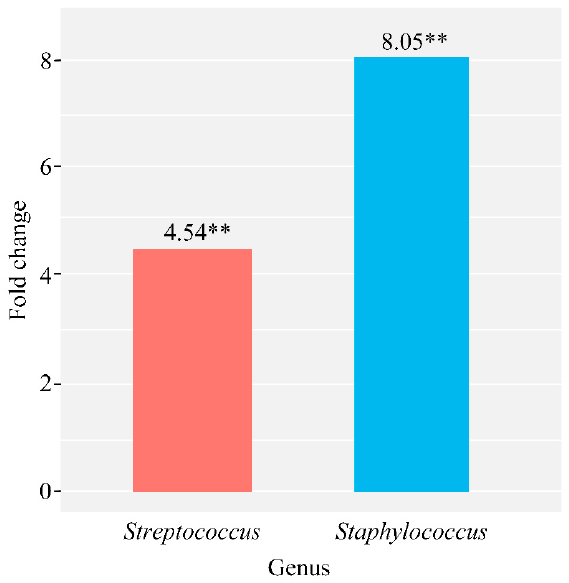
Figure 5. Quantitative changes in the total microbiome composition of milk samples taken from cows with subclinical mastitis compared to acute catarrhal mastitis ( ∗∗ p ≤